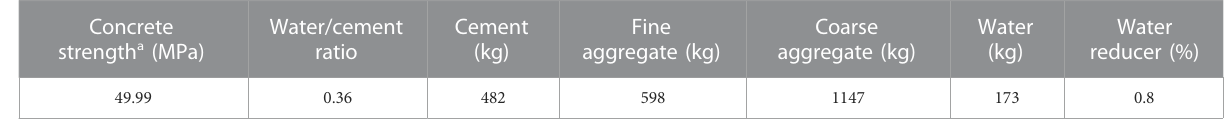
TABLE 1 Concrete material and mix proportions.